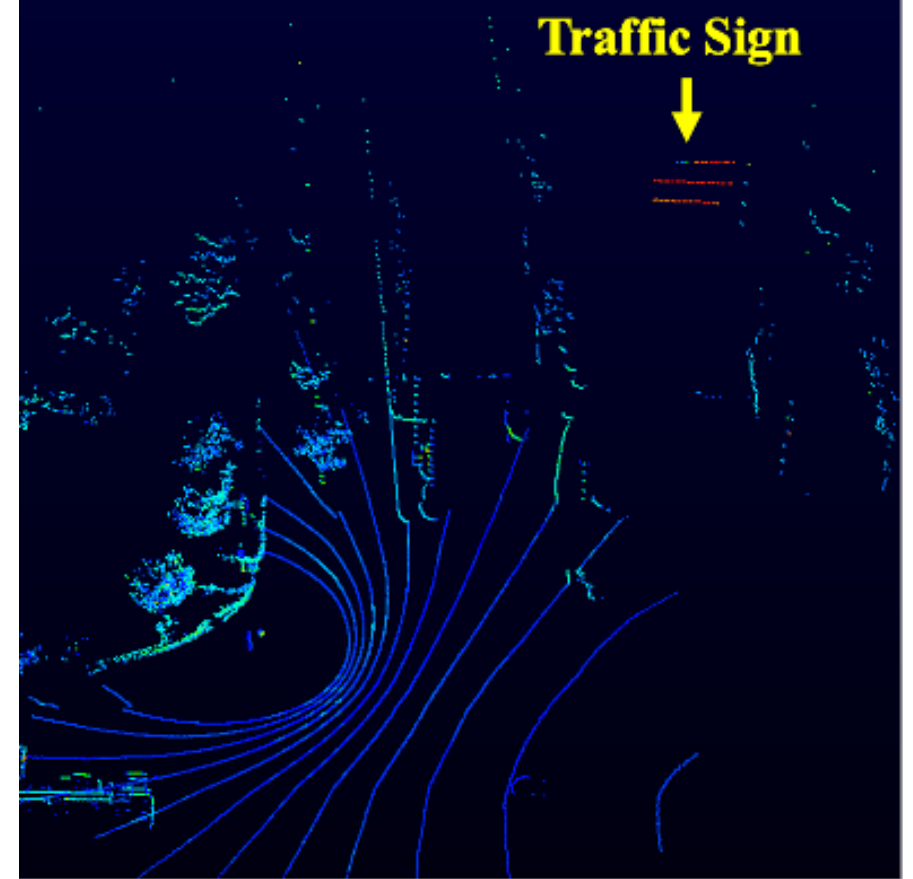
Figure 5. Traffic signs in point cloud